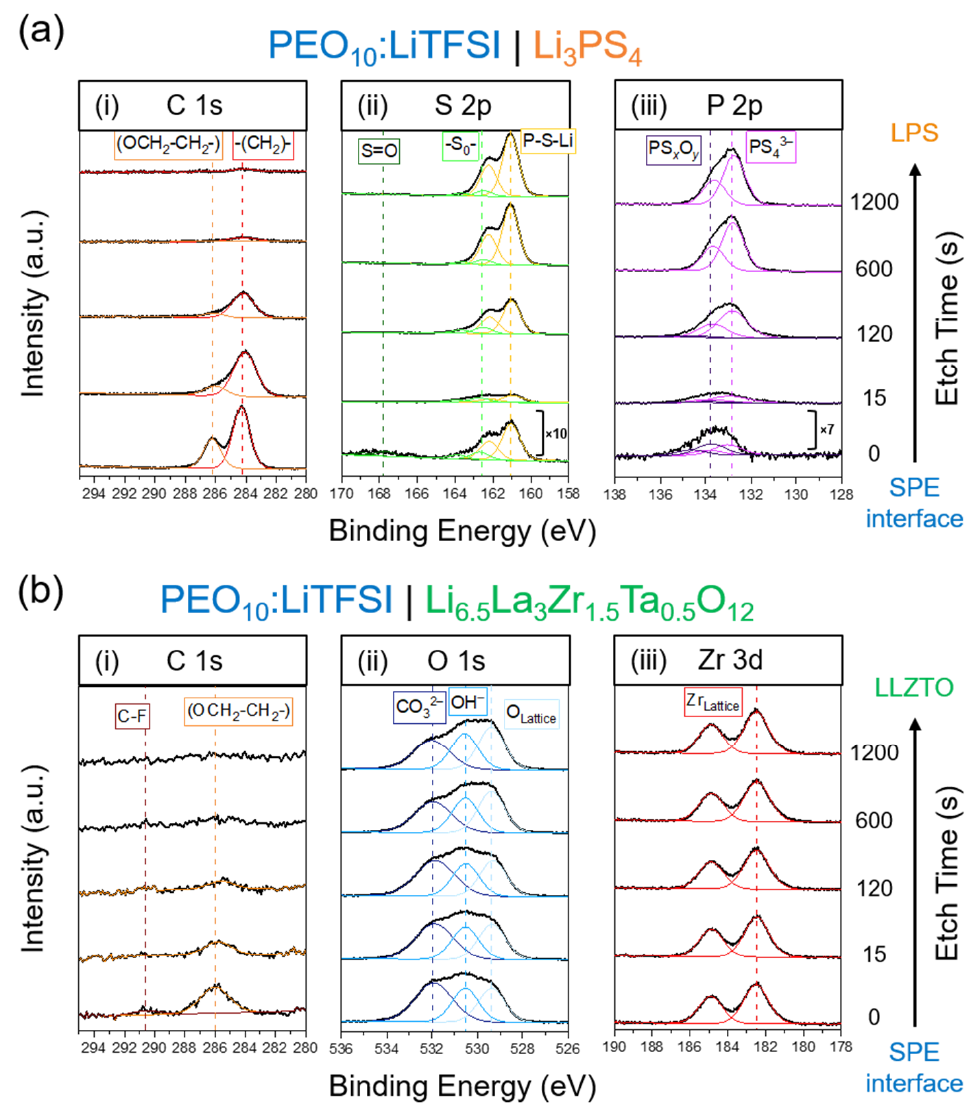
Figure 2. The depth-profiled XPS of ( a ) the PEO 10 :LiTFSI/LPS interface showing the ( i ) C 1s; ( ii ) S 1s and ( iii ) P 2p regions of the spectra; and ( b ) the PEO 10 :LiTFSI/LLZTO interface showing the ( i ) C 1s; ( ii ) O 1s and ( iii ) Zr 3d regions of the spectra.